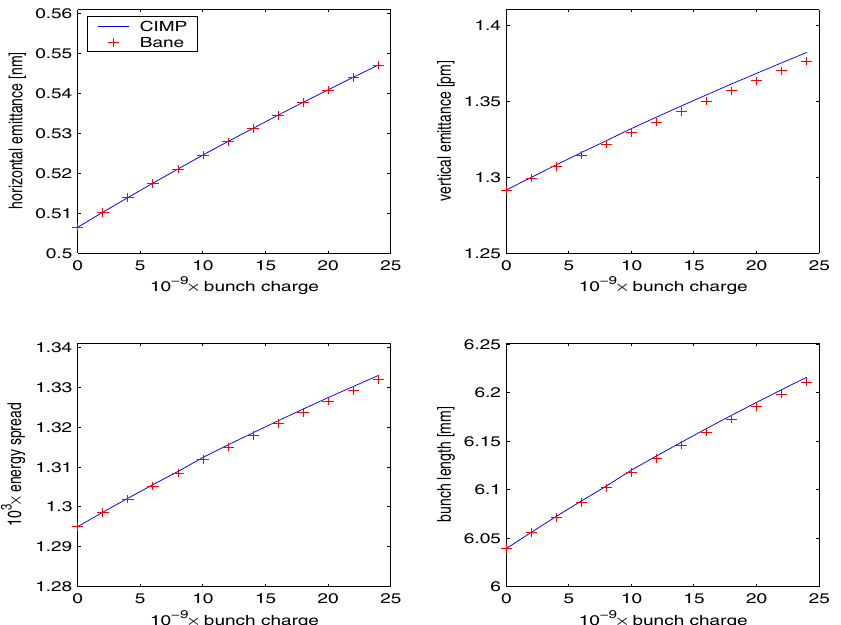
FIG. 3. (Color) Equilibrium transverse emittances, relative energy spread, and rms bunch length vs bunch charge for the ILC damping